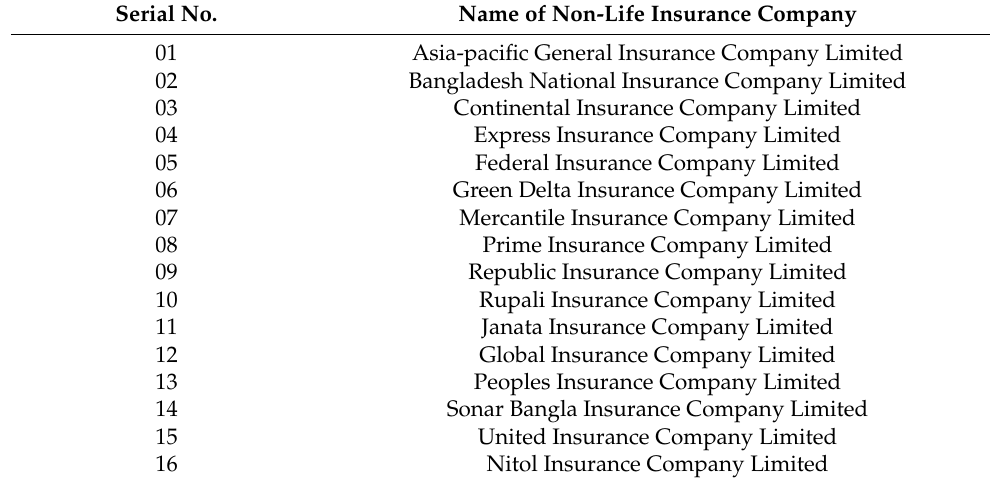
Table 1. List of non-life insurance